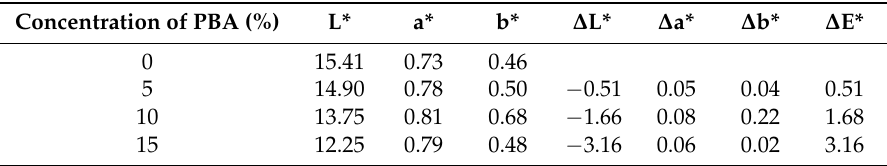
Figure 7. Pictures of printing and handwriting on PBA-coated paper after four months. The coating concentration was 0, 5, 10 and 15%, respectively, from the top to the bottom. Table 2. Color difference values of blank control paper and paper coated with 5, 10 and 15% of PBA. Each value was an average of three